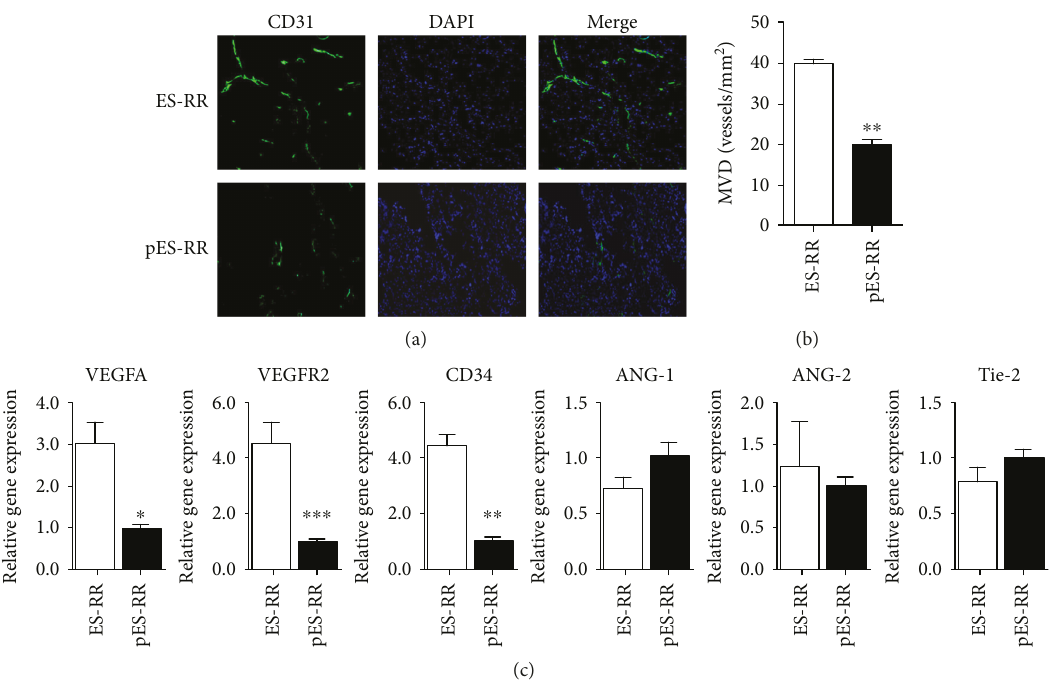
Figure 4: Analysis of teratoma angiogenesis. (a) Angiogenesis observed in pES-RR group and ES-RR group by CD31 immuno fl uorescence staining. (b) Microvessel density (MVD) of teratoma tissue was measured by computer image analyzing system. (c) The expression of CD34/VEGF/VEGFR2 was signi fi cantly lower in pES-RR group compared with ES-RR group, whereas there was no signi fi cant di ff erence in the expression of ANG-1/ANG-2/Tie-2 between these two groups. ∗ P < 0 05 ; ∗∗ P < 0 01 ; ∗∗∗ P < 0 001 .